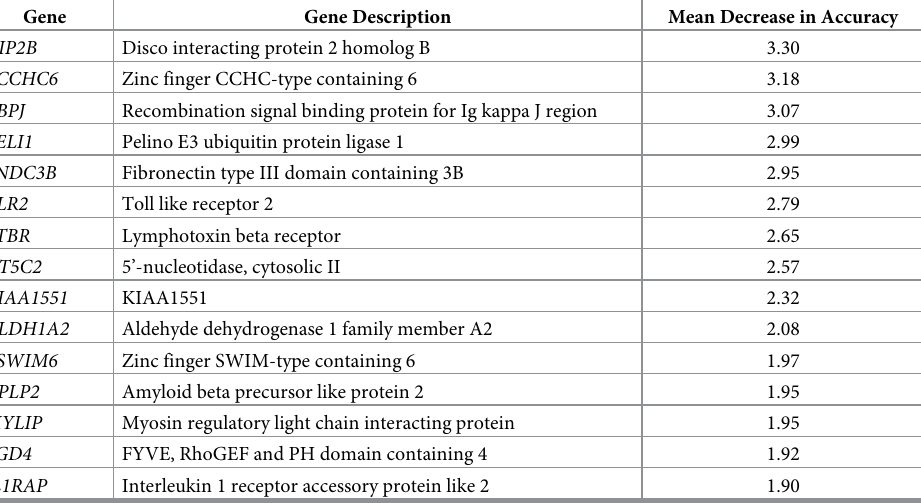
Table 2. Top 15 genes associated with development of moderate adverse events in LF patients after treatment as identified by random forest analysis. Gene Gene Description